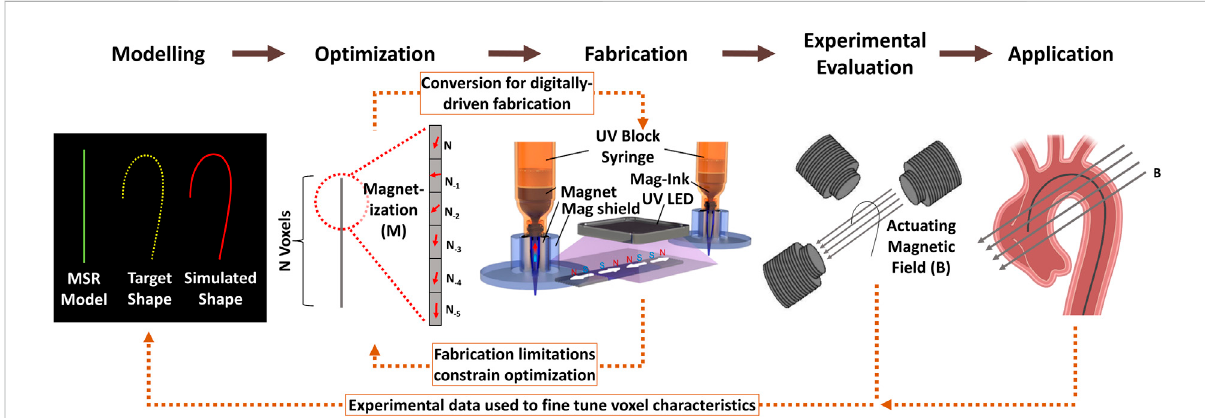
FIGURE 1 Idealized approach for voxel encoding and programmable MSR development. The presented example involves a voxelated biomedical soft magnetic continuum robot for cardiac catheterization. In modelling, the relevant target de fl ection path is extracted from patient data and modelled via fi nite element software. The model along with target de fl ection requirements are utilized by an integrated optimization protocol (e.g., a genetic algorithm) to determine voxel characteristics such as distribution, scale and magnetization. An automated, digitally-driven fabrication protocol (e.g. DIW) simultaneously fabricates and magnetizes 3D voxels throughout the structures in accordance with optimized data. The fabricated MSR is actuated and controlled in experiment via actuating magnetic fi elds. Experimental data may be integrated with the modelling and optimization protocol to fi ne tune voxel characteristics throughout further MSR design iterations. When an optimal shape forming con fi guration is achieved, the MSR may be deployed for application-speci fi c evaluation. The critical bi-directions links between optimization and fabrication are highlighted. “ Fabrication ” sub fi gure adapted from Ma et al.